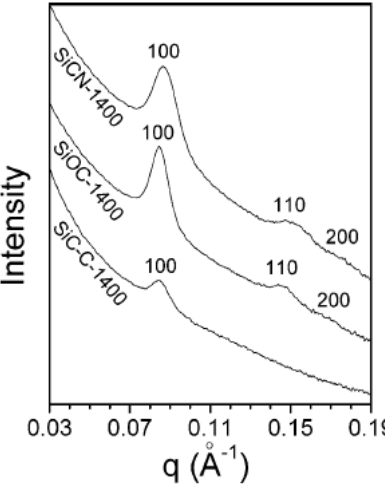
Figure 10. Small angle X-ray scattering (SAXS) patterns for ordered mesoporous SiC–C composites and derived SiOC-1400 and SiCN-1400 samples (reprinted with permission from reference [238]; Copyright 2007 American Chemical